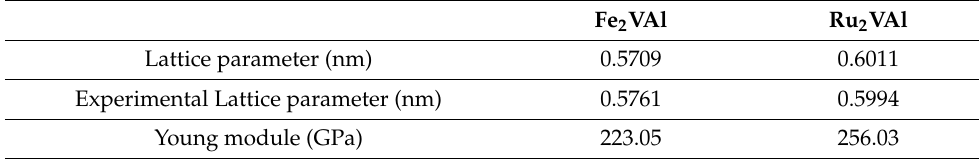
Table 1. Lattice parameter and Young’s modulus of Fe 2 VAl and Ru 2